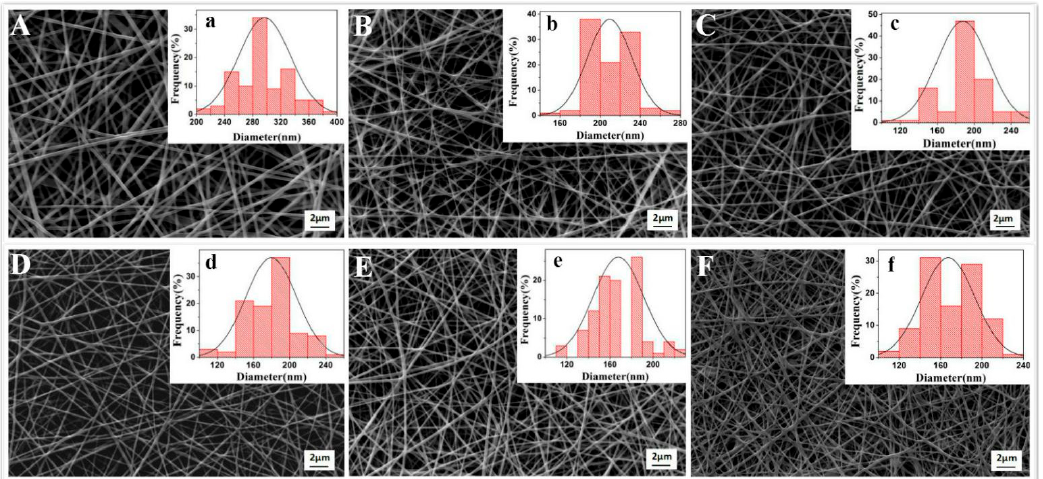
Figure 1. Photos of feather keratin/poly(vinyl alcohol)/poly(ethylene oxide) (FK/PVA/PEO) composite nanofibers with different AgNPs content.